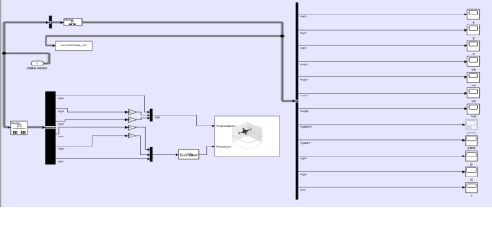
Figure 13. 3D Visualizer system